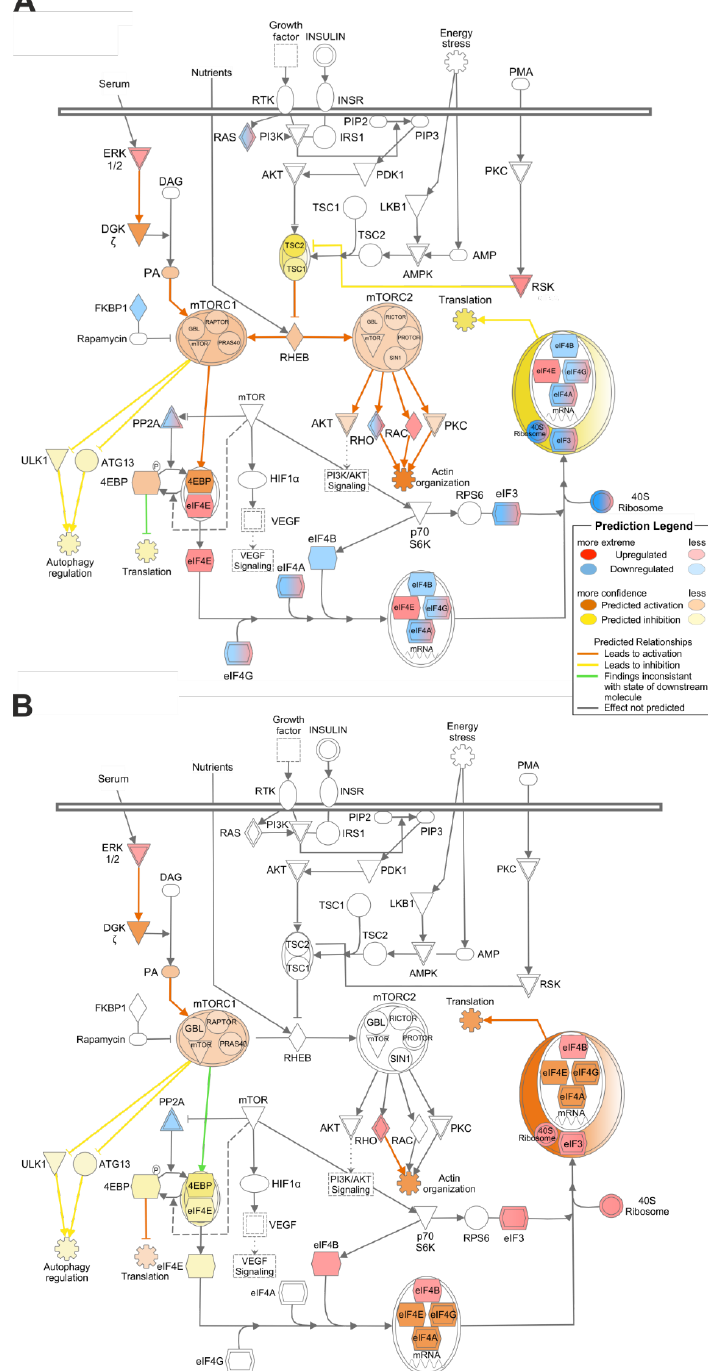
Figure 3. Impact of the hepatocyte-specific knockout of Hedgehog signalling on mechanistic target of rapamycin (mTOR) signalling. A-B: IPA analysis of mTOR signalling based on proteome data of male ( A ) and female ( B ) SAC mice.